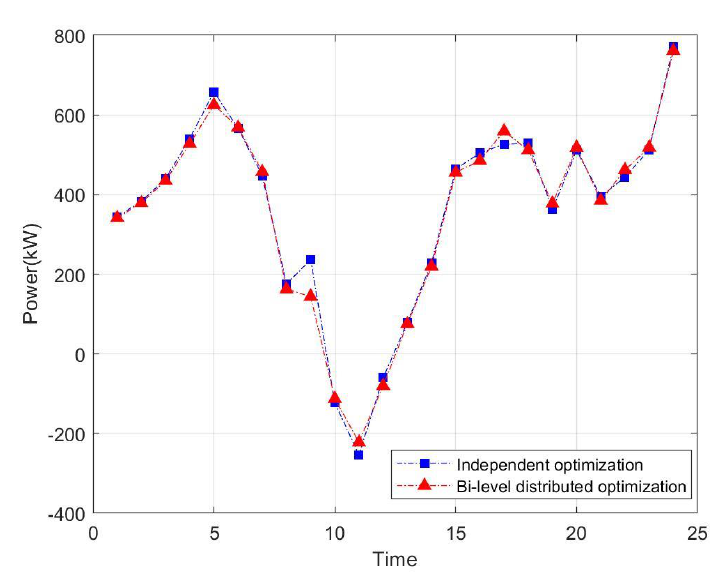
Figure 11. Result of two optimization methods of DSO2.